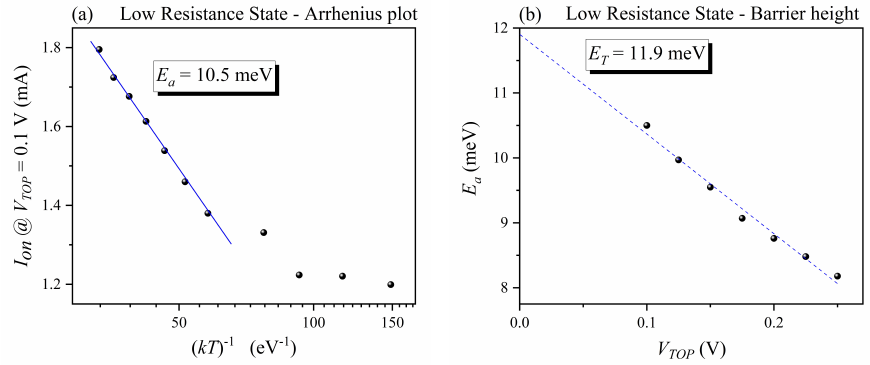
Figure 4. Arrhenius plot ( a ), and barrier height of hopping and average hopping distance ( b